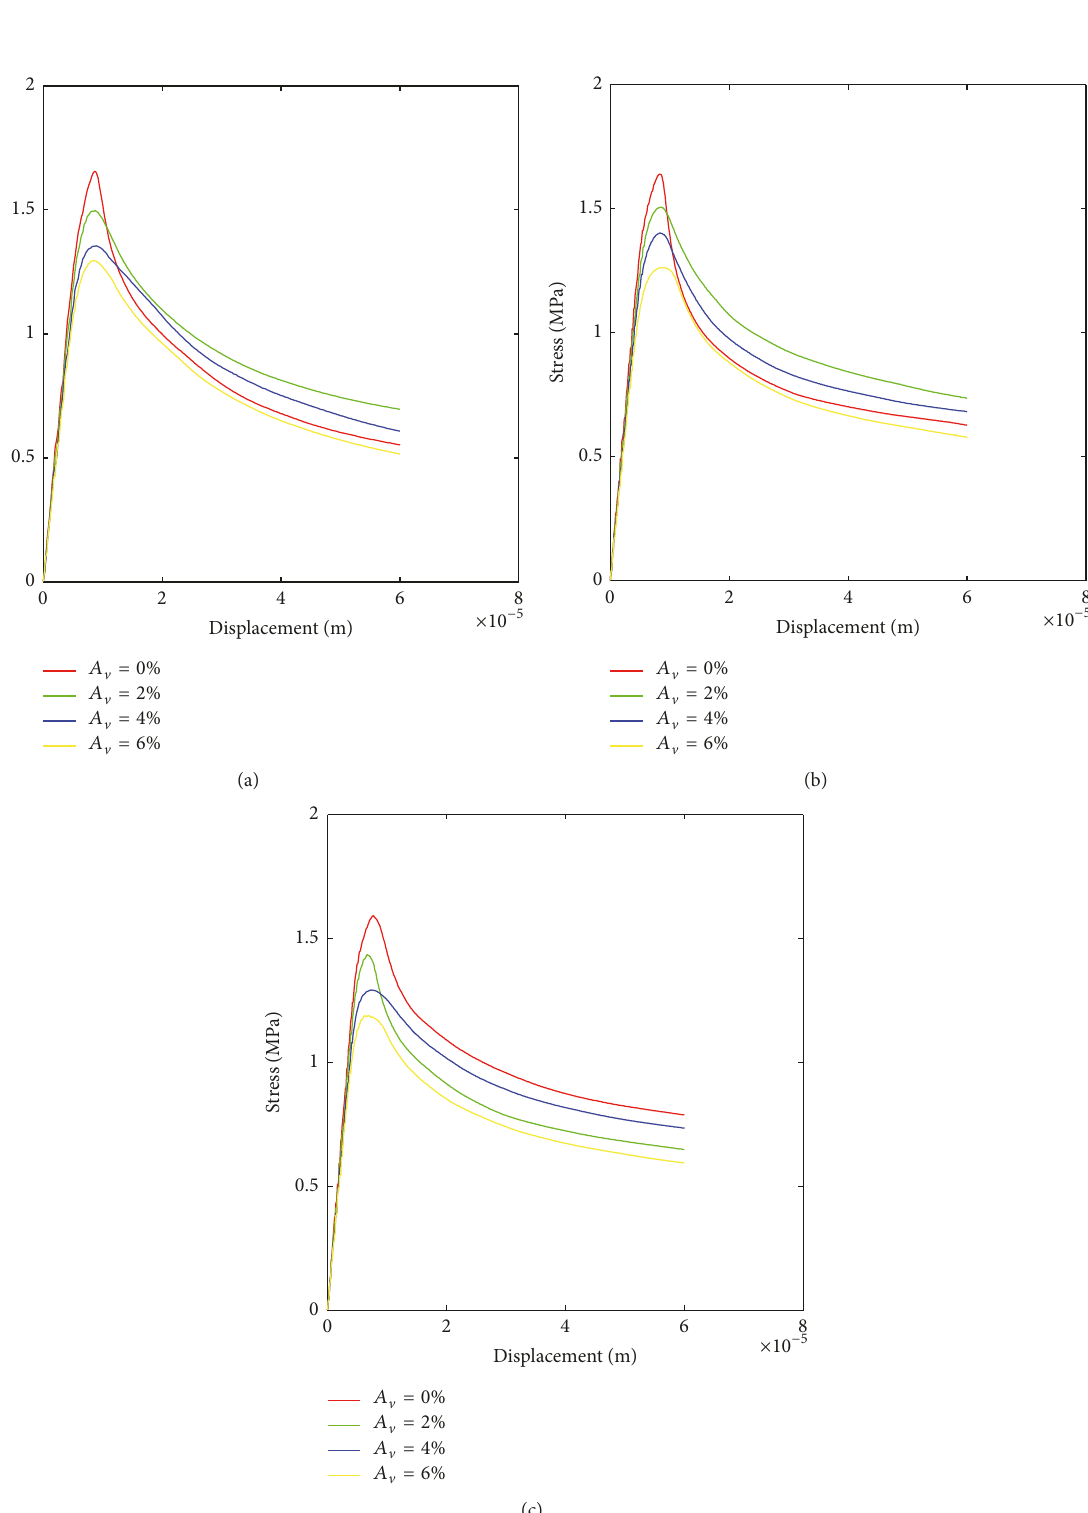
Figure 12: Stress-displacement curves for (a) 𝐴 𝐹 = 30 %; (b) 𝐴 𝐹 = 40 %; (c) 𝐴 𝐹 = 50